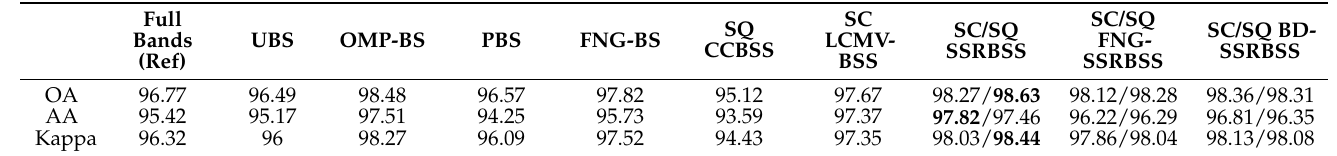
Table 10. HybridSN classification results of using the bands described in Table 4 for the Purdue dataset.